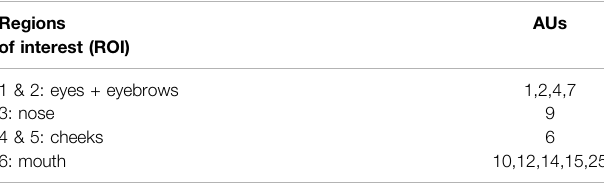
TABLE 1 | Facial regions and corresponding AUs: we focus on the local region where characteristics of MiE appear. Regions of interest